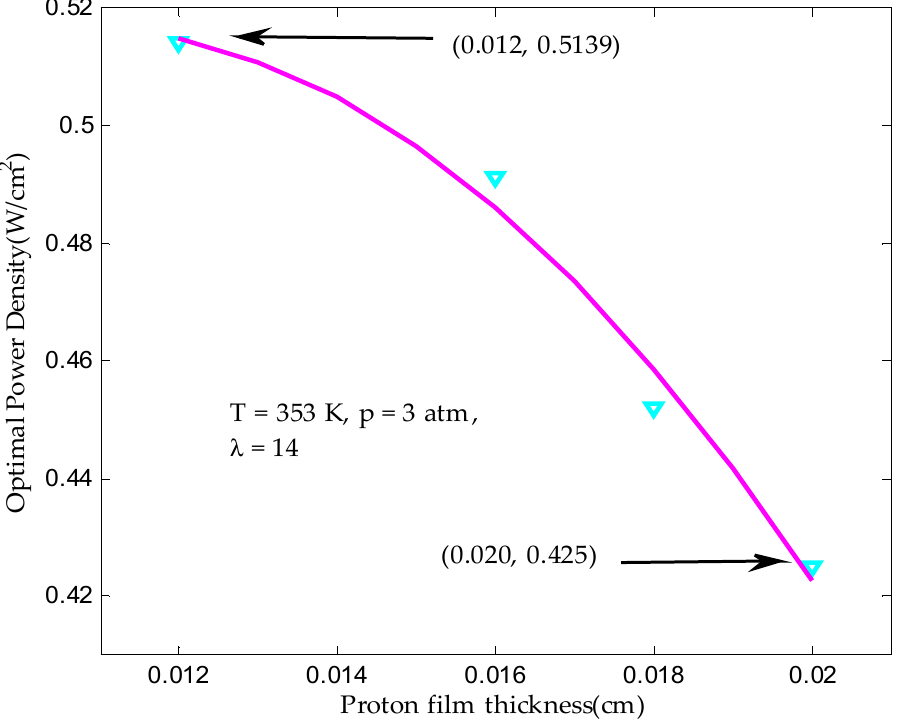
Figure 5. Optimal output power density varying with membrane thickness.